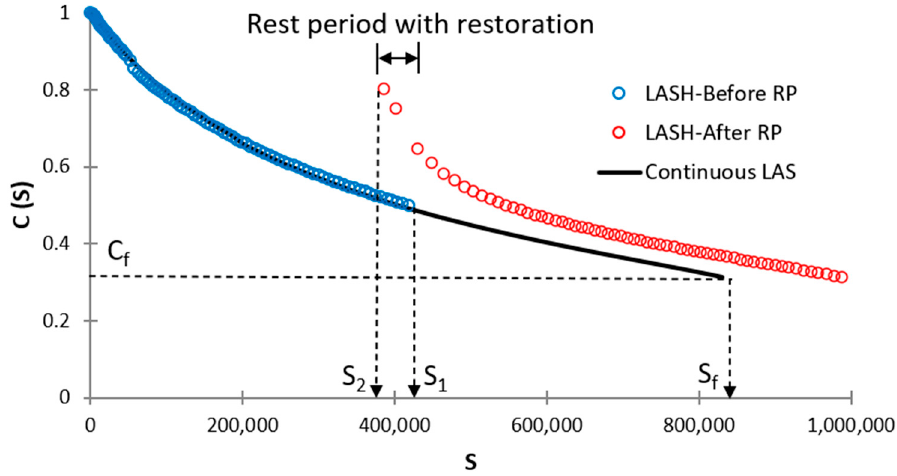
Figure 7. Schematic illustration of continuous LAS test, LASH test and calculating %Rs.